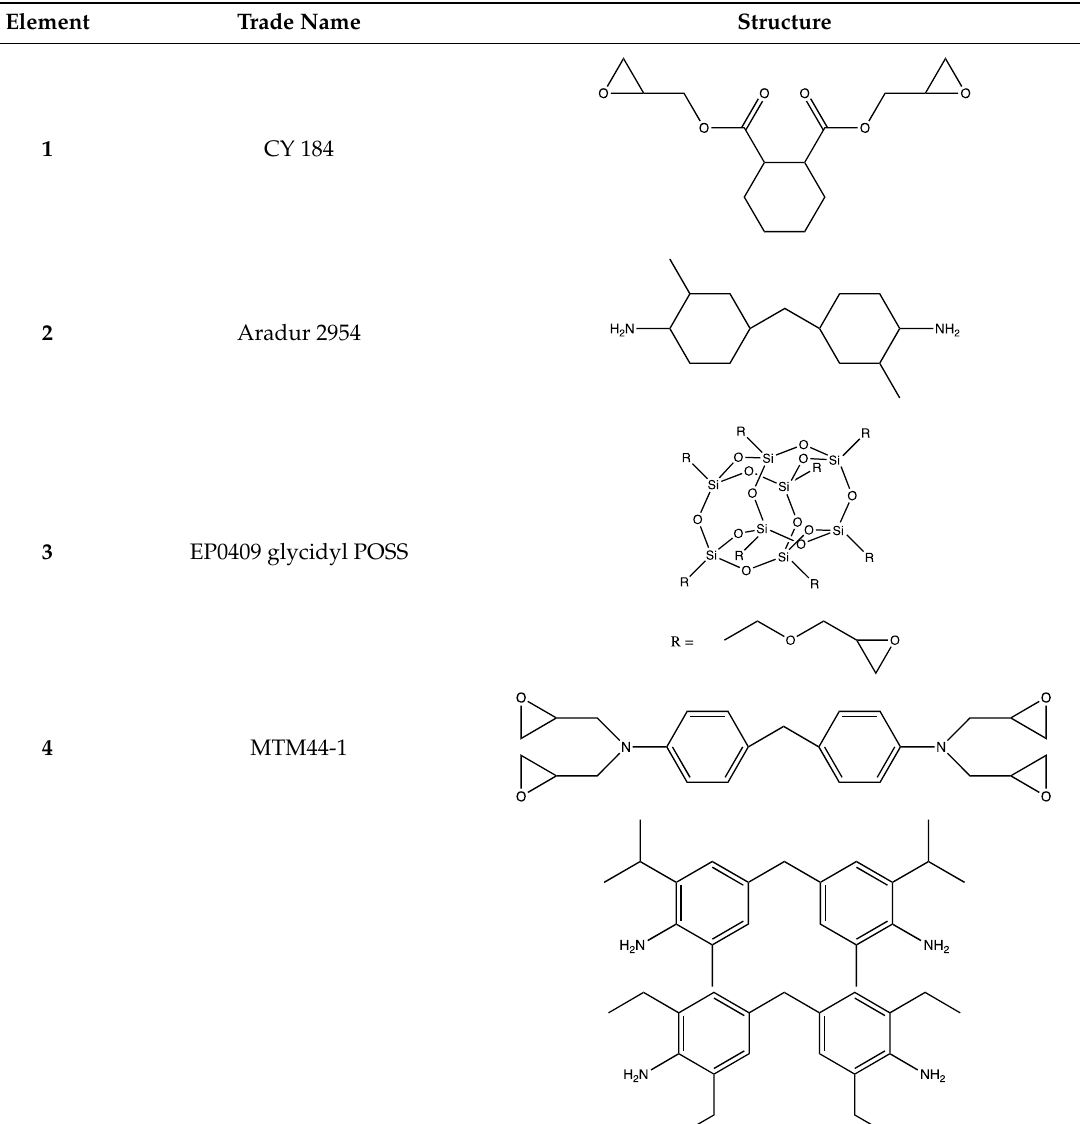
Table 1. The structures of the chemicals used in this work.